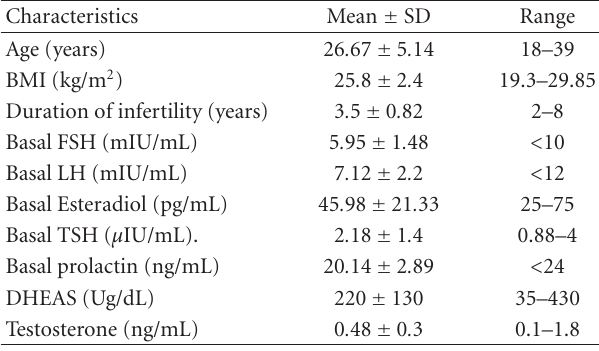
Table 1: Patient and cycle characteristics.